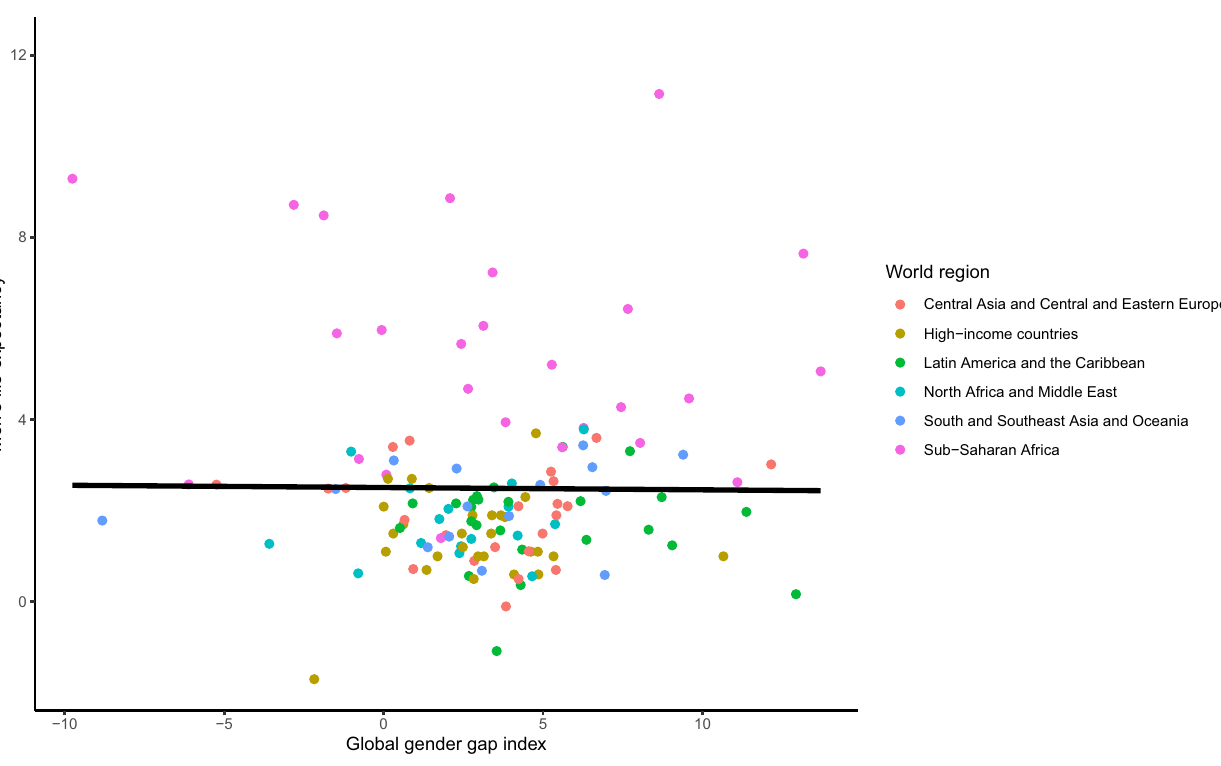
Fig 4. Association between change in the mGGGI and change in men’s life expectancy between 2010 and 2020. The scatterplot displays the linear regression line for the association between the change in the mGGGI and the change in men’s life expectancy (-0.05 [-1.08 to 0.99], p-value 0.928).